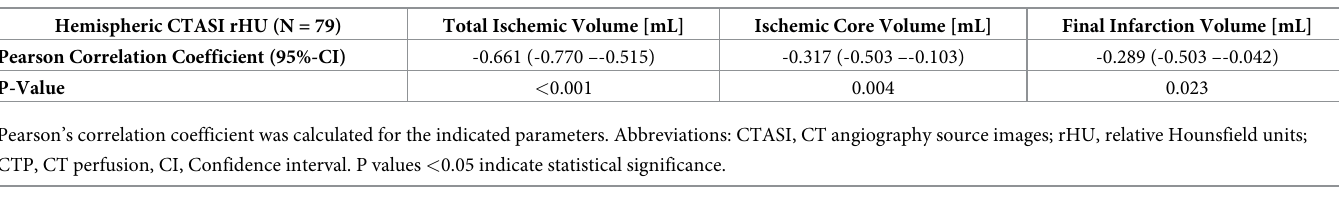
Table 4. Correlation of hemispheric CTASI rHU with CTP parameters and final infarction volume. Hemispheric CTASI rHU (N = 79)